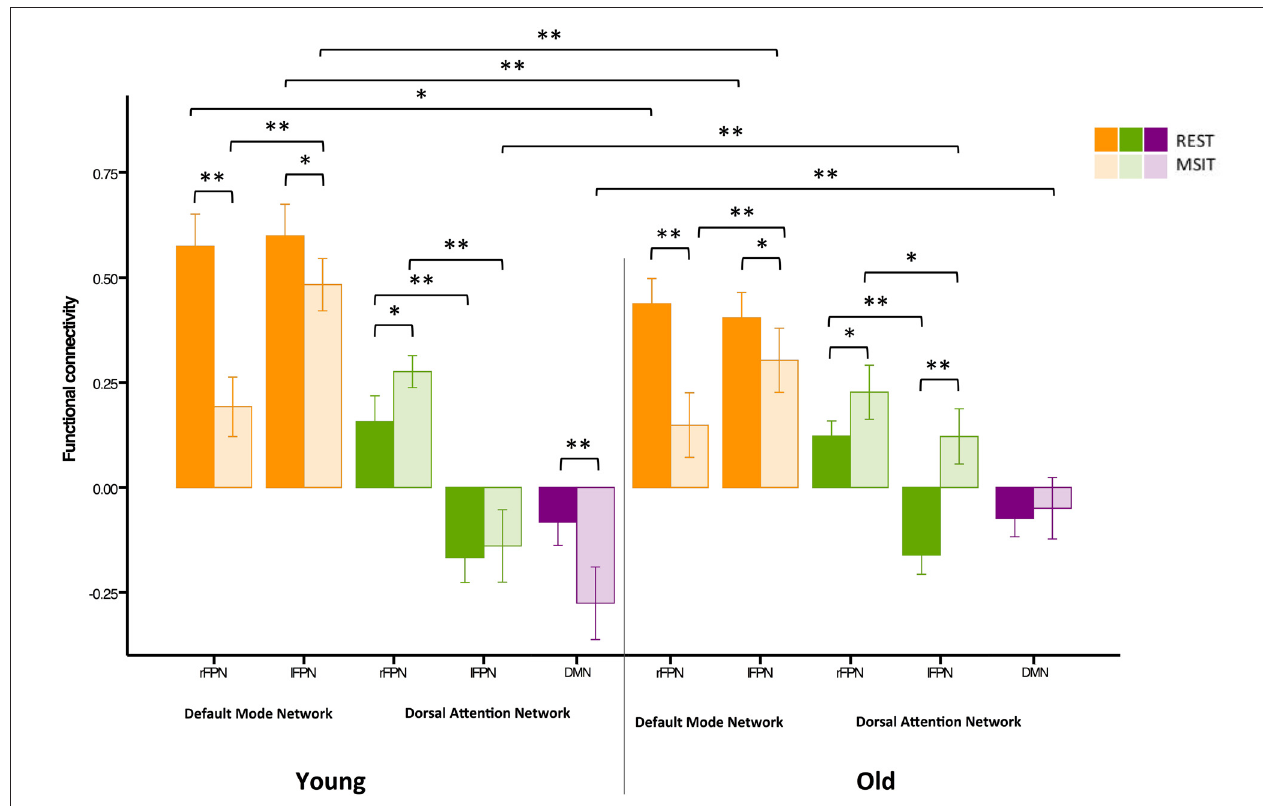
FIGURE 5 | Functional connectivity among the DMN, FPN and DAN during rest and the MSIT for younger and older adults. The young had higher FPN-DMN connectivity than the old in both conditions. However, both groups showed a decrease in inter-network functional connectivity during the MSIT when compared to rest. Both groups also showed an increase in right FPN (rFPN)-DAN connectivity during the MSIT compared to rest, but there were no differences between young and old. Although there were also no differences between the groups in lFPN-DAN connectivity during rest, the old showed increased connectivity during the MSIT, whereas the young group retained similar levels of (negative) connectivity. DMN-DAN connectivity levels did not significantly differ between the age groups at rest, but the young showed increased negative connectivity during the MSIT, whereas the old did not. ∗ p < 0.05; ∗∗ p < 0.001.